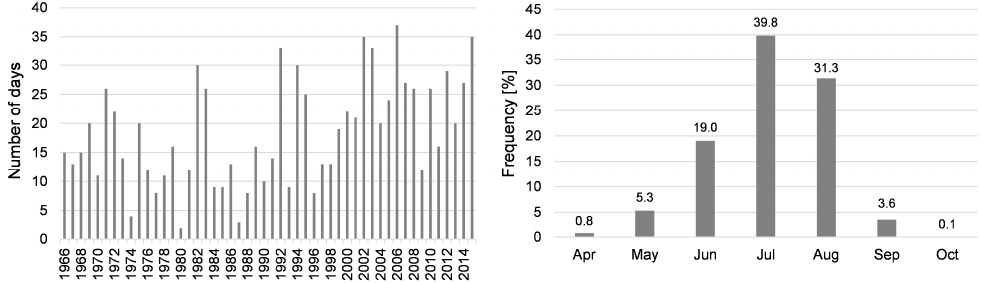
Figure 3. Number of hot days in 1966–2015 and the frequency of hot days’ occurrence in certain months.